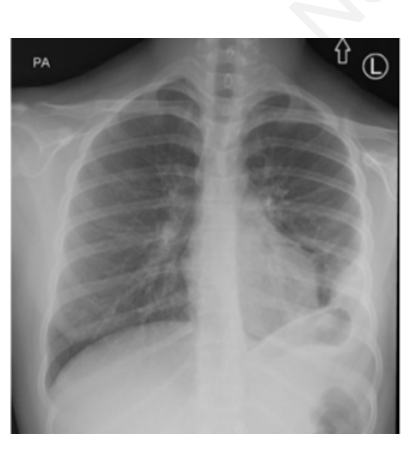
Figure 1. Frontal chest radiograph obtained at presentation shows left lung base pleural based